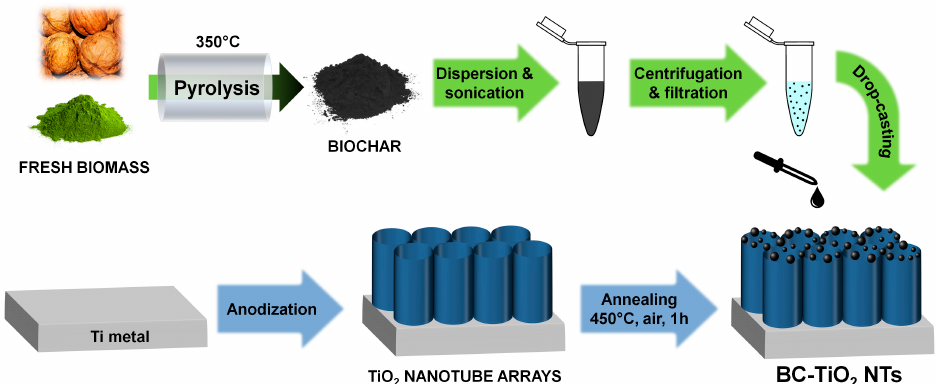
Figure 1. Schematic representation of the steps involved in the fabrication of BC-TiO 2 photocata- lysts.